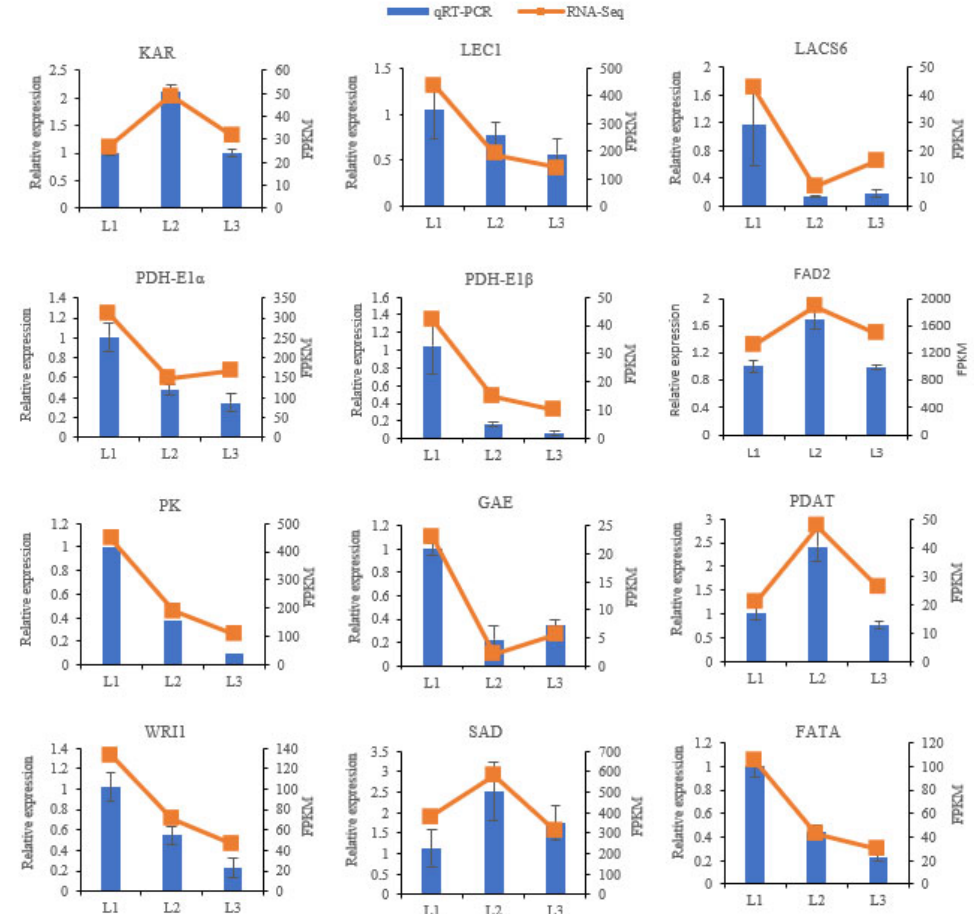
Figure 11. Expression patterns of twelve genes, as determined by the transcriptomic data and qRT − PCR results. The y -axis on the right represents the FPKM value obtained by RNA − seq; the y -axis on the left shows the relative gene expression levels (2 − ∆∆ C t ) analyzed by qRT − PCR. The x -axis represents the different samples. Bars represent mean ± SE (n = 3). FPKM represents the fragments per kilobase per million. L1 was 60 DAP, L2 was 90 DAP, and L3 was 120 DAP. KAR, 3 − oxoacyl − ACP reductase; LEC1, nuclear transcription factor Y subunit B − 6; LACS6, long − chain acyl − CoA syn- thetase 6; PDH − E1 α , pyruvate dehydrogenase E1 component alpha subunit; PDH − E1 β , pyru- vate dehydrogenase E1 component beta subunit; FAD2, fatty acid desaturase 2; PK, pyruvate ki- nase; GAE, UDP − glucuronate 4 − epimerase; PDAT, phospholipid:diacylglycerol acyltransferase; WRI1, ethylene − responsive transcription factor WRI1; SAD, stearoyl − ACP − desaturase; FATA, fatty acyl − ACP thioesterase